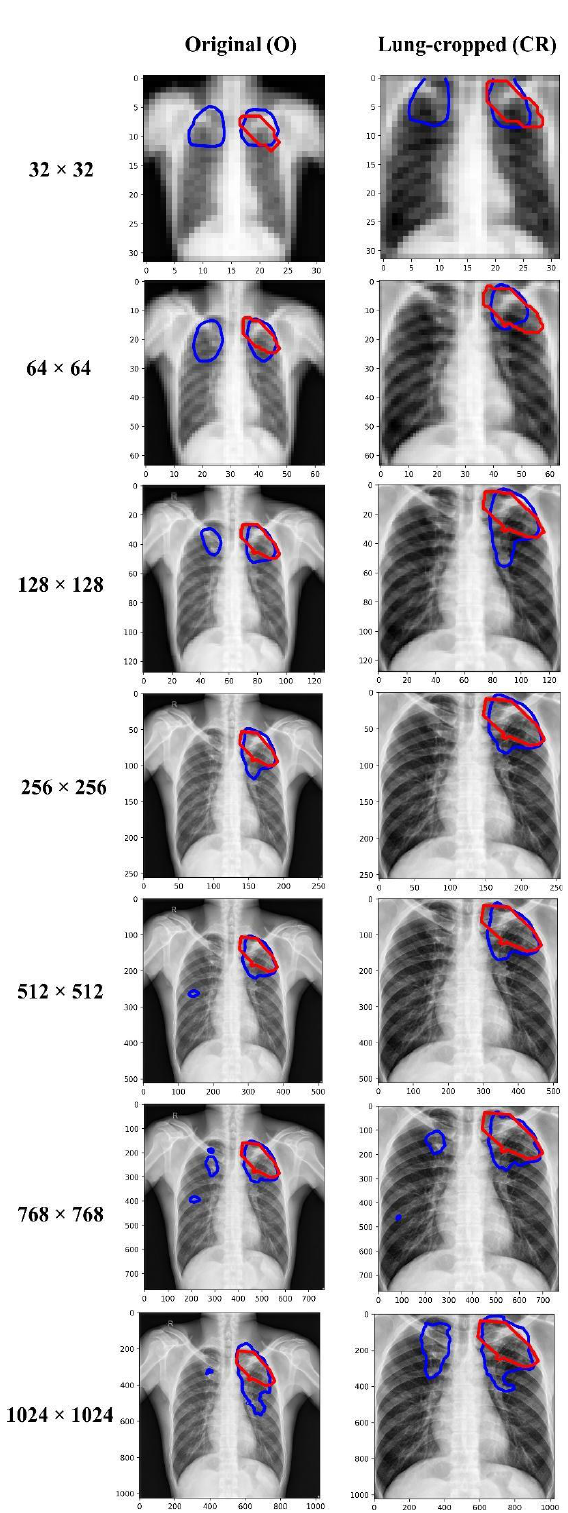
Figure 5. Visualizing and comparing the segmentation predictions of the Inception-V3 UNet model trained at various image resolutions, using a sample original, and its corresponding lung- cropped CXR/mask from the test set. The red and blue contours denote ground truth and predictions,